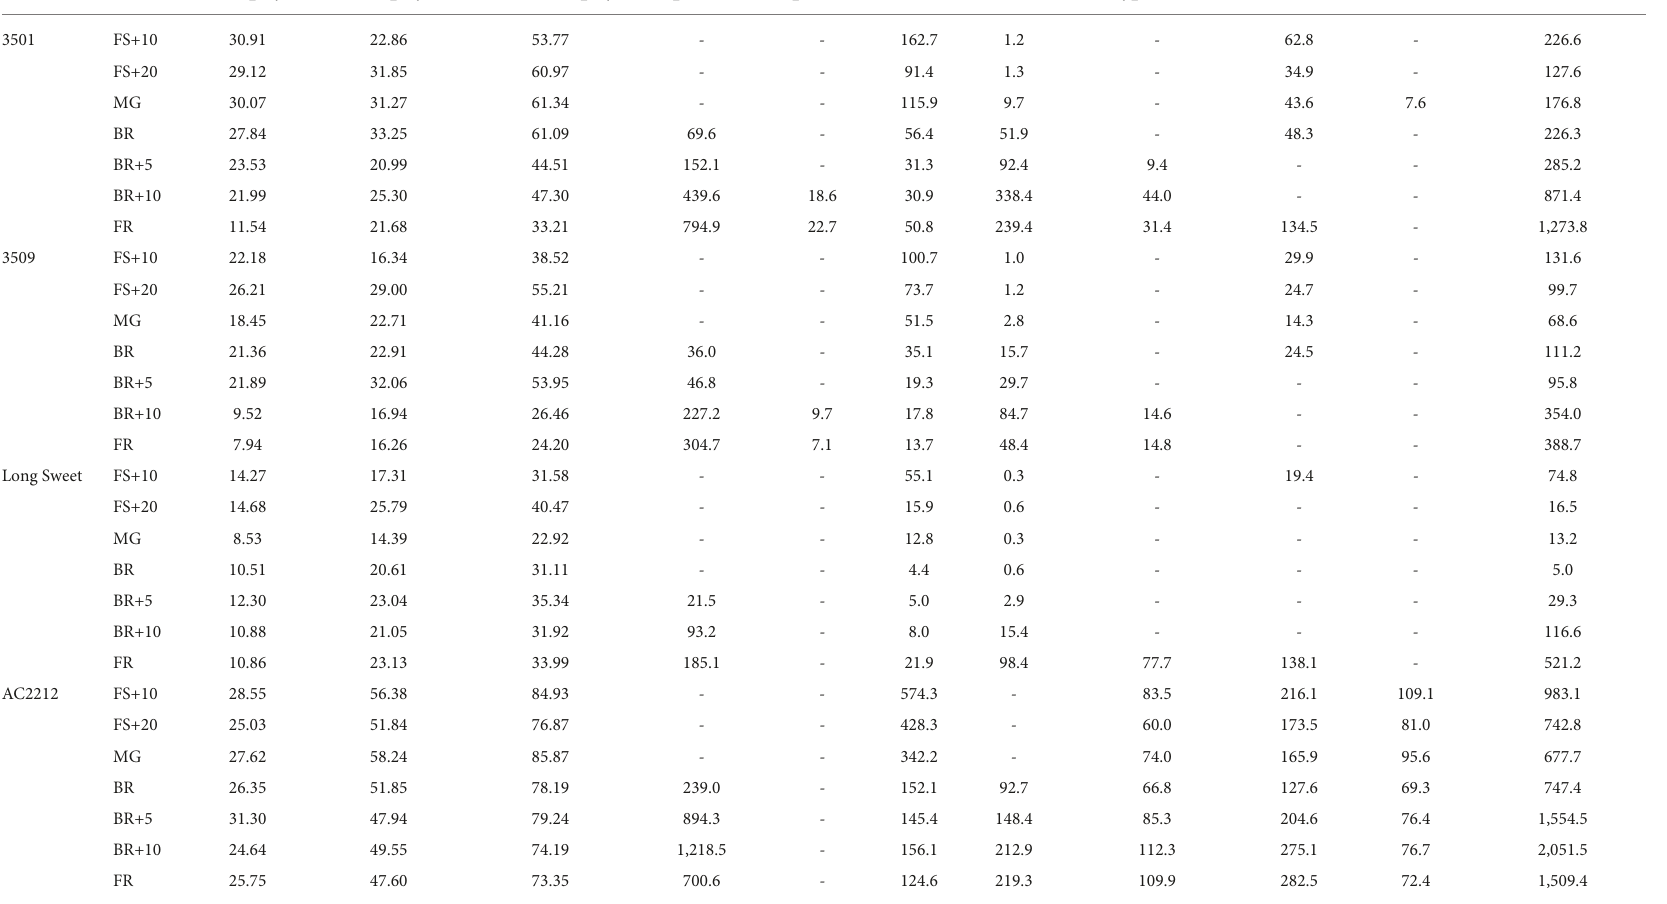
TABLE 1 Carotenoid contents of four accessions throughout fruit development and